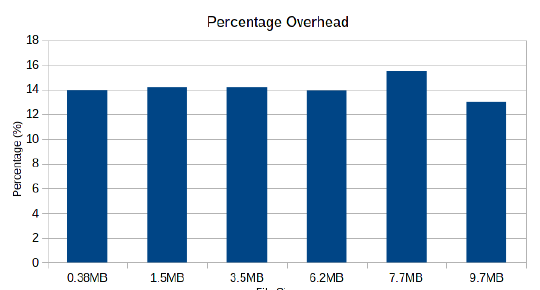
Figure 8. File Transfer Percentage Overhead. Due to MTU of 1280 and extra 40-byte header for IP encapsulation, there is a 14% overhead in the extra number of bytes sent over the network for the same file size when compared to WiFi.